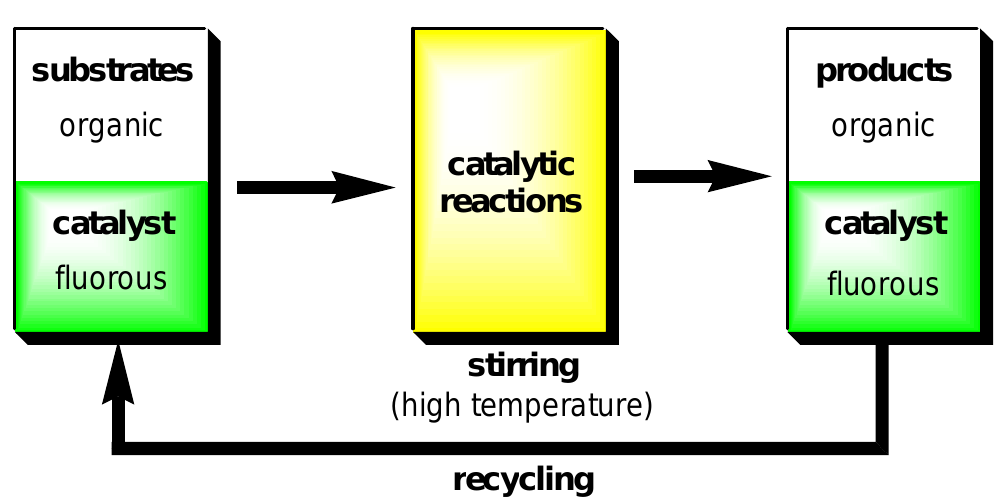
Figure 1. Fluorous biphasic